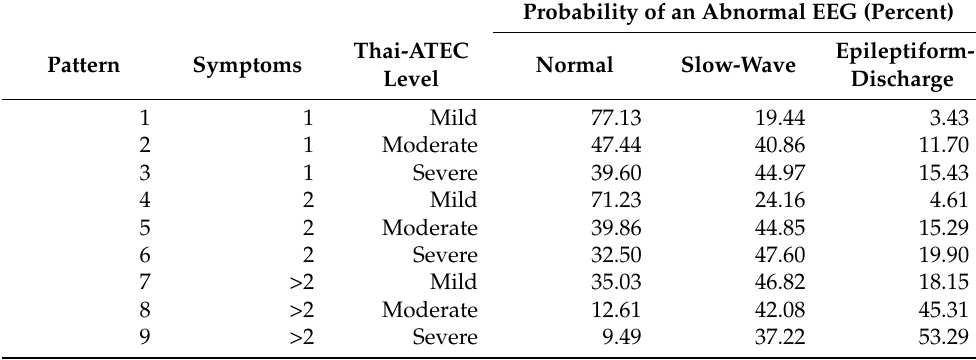
Table 5. The probability of an abnormal electroencephalograph from model prediction according to the number of symptoms and the Thai-ATEC (Thai autism treatment evaluation checklist) level.